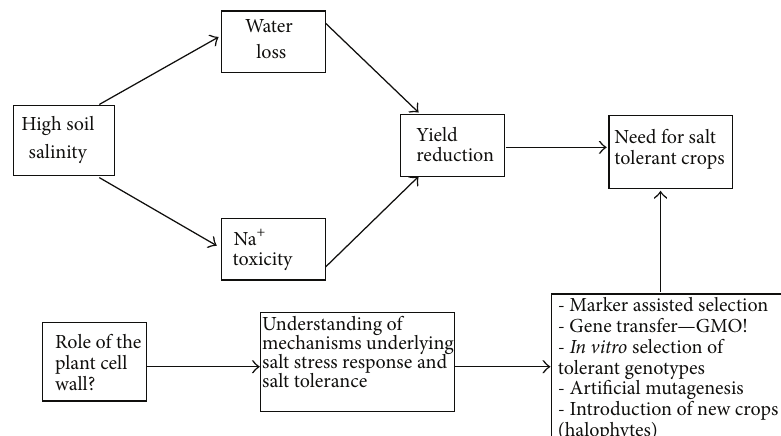
Figure 1: Schematic representation of the negative effects of high soil salinity on crop yield and the strategies to overcome it. The role of the plant cell wall in salt stress response and tolerance is depicted as one of the least known aspects and extensive studies in this area are needed in order to understand the mechanisms of salt tolerance and apply this knowledge to the strategies for salt tolerant crops